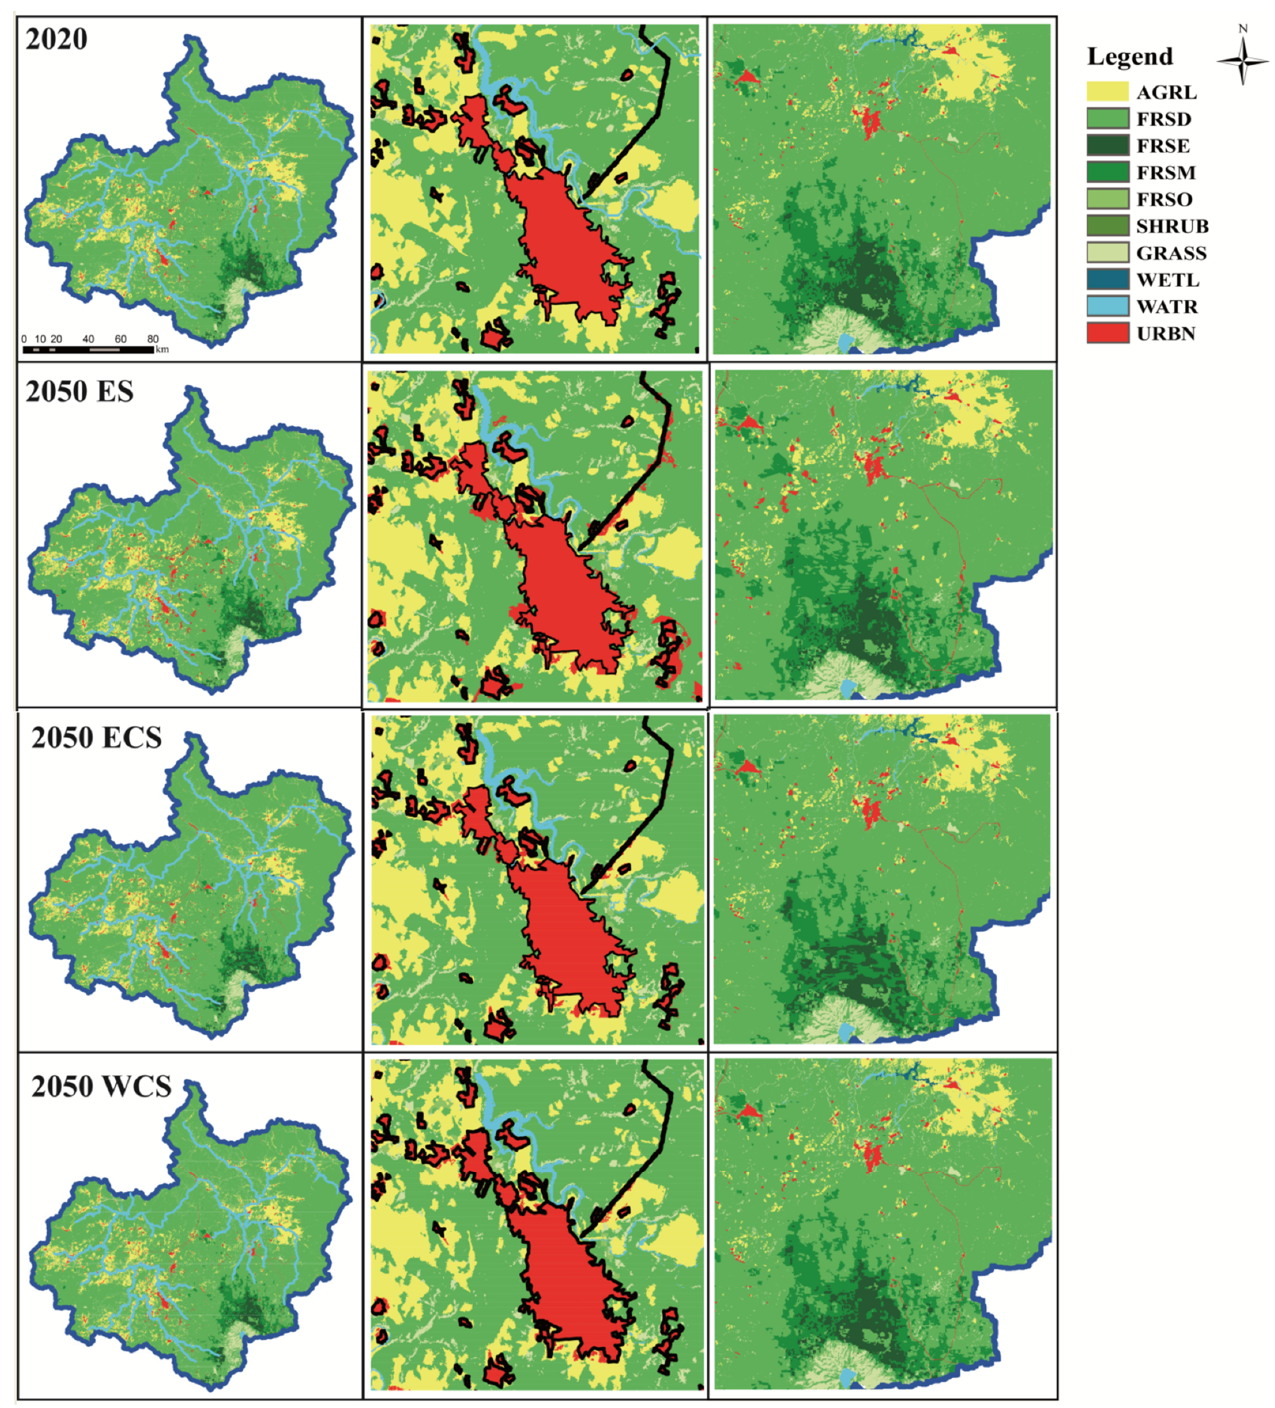
Figure 7. Land use planning maps of the three scenarios in 2050, the first column is land use map, the second column is the magnification of Fusong County, and the third column is the magnification of Changbai Mountain area. Each land use name code is the same as in Table 1.